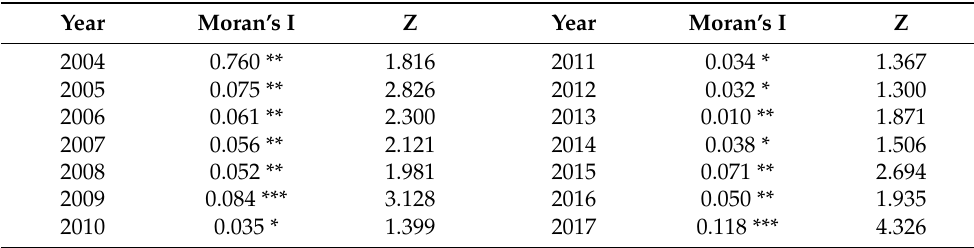
Table 3. Spatial correlation test.